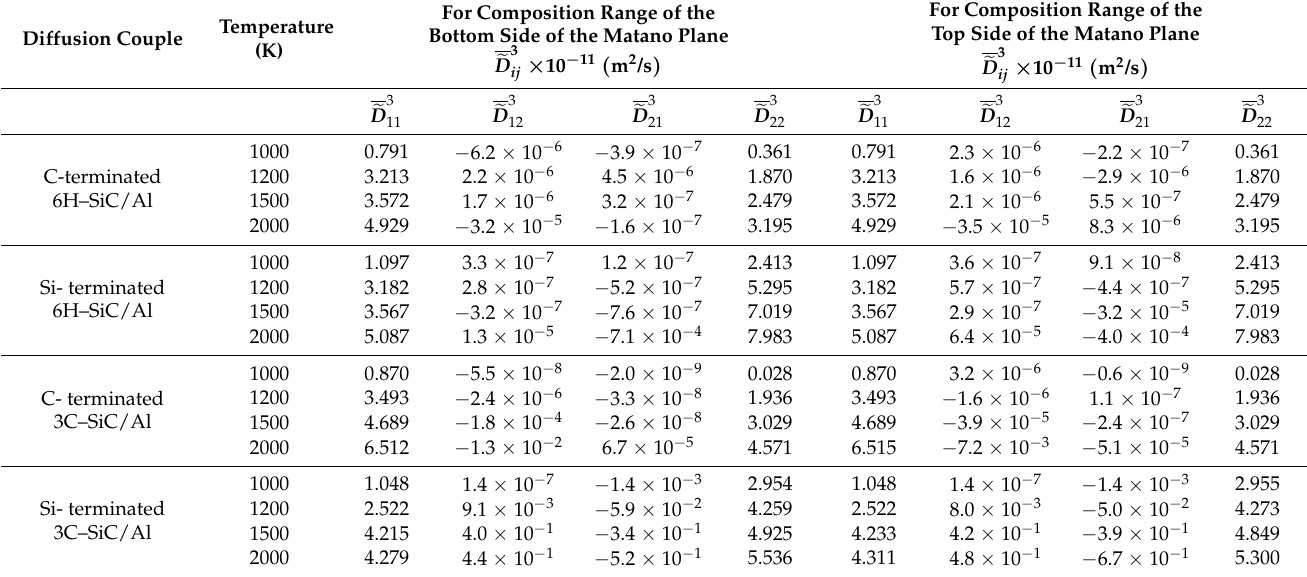
Table 3. Average values of ternary main and cross-interdiffusion coefficients on each side of the Matano plane after maintaining the system at the pre-set temperature for 6 ns (indices: 1 = Al; 2 = Si; 3 =